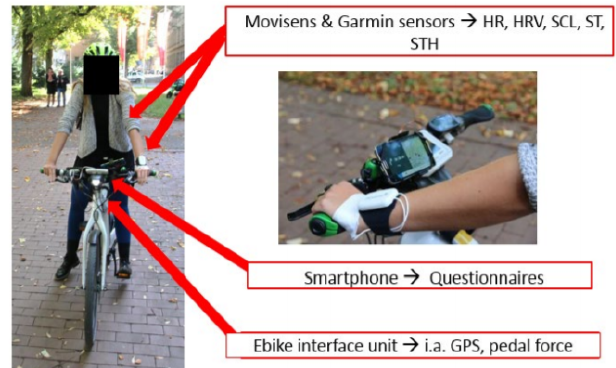
Figure 1. Ebike and proband with measurement instruments and sensor (Double-Blind-RiviewREF,